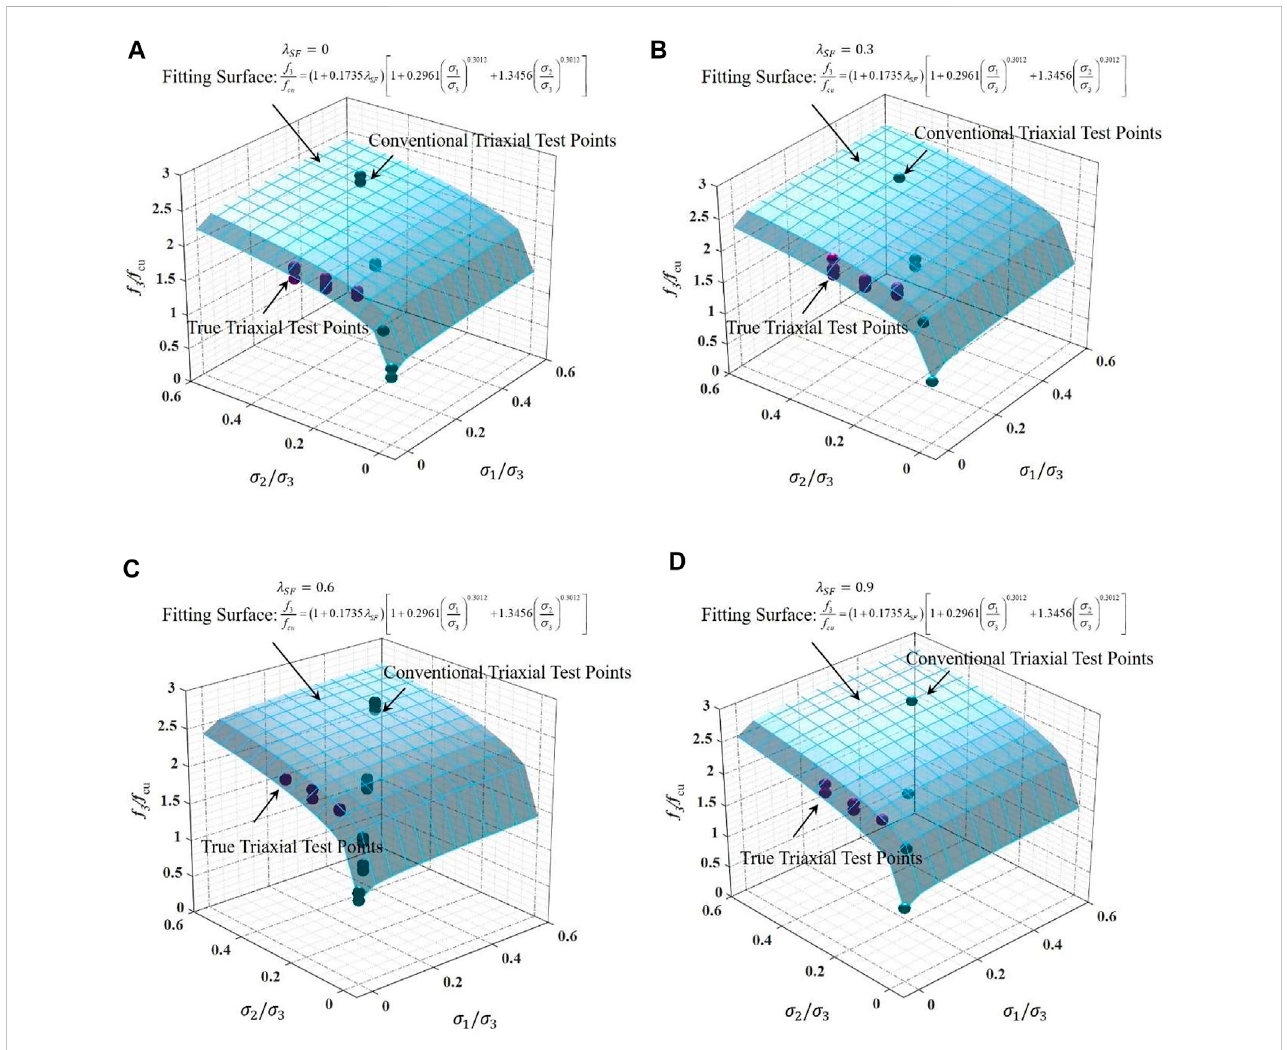
FIGURE 8 Fitting result diagram: (A) λ SF (cid:1) 0, (B) λ SF (cid:1) 0 . 3, (C) λ SF (cid:1) 0 . 6, and (D) λ SF (cid:1) 0 . 9.